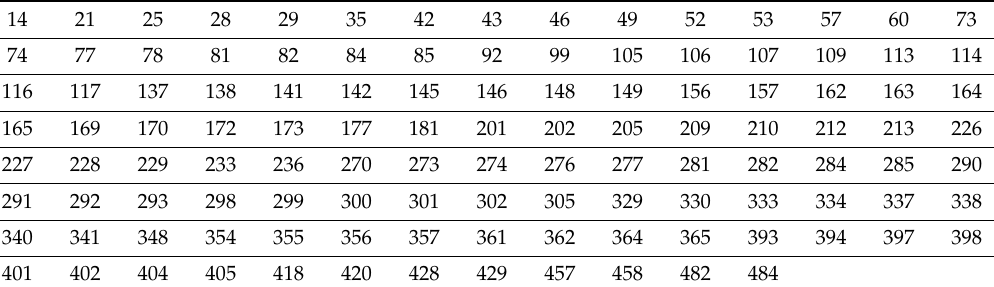
Table 7. x4 corresponding to block R texture template (decimal).